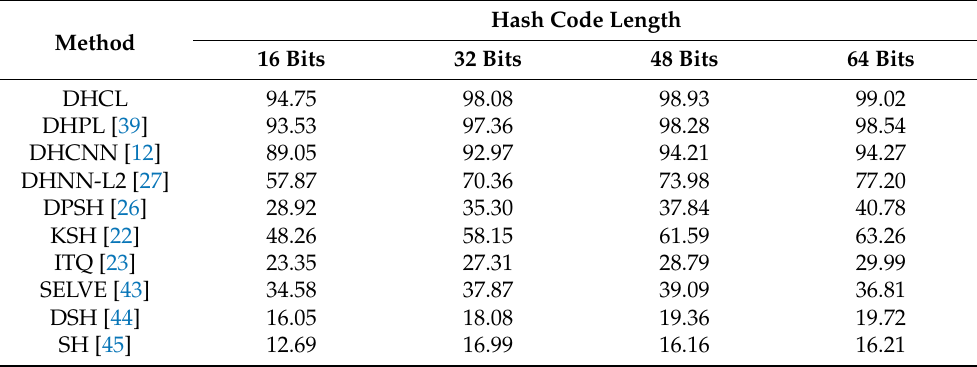
Table 2. Results of different retrieval methods on AID. The latest hash methods, including DHPL, DHCNN, DHNN-L2, DPSH, KSH, ITQ, SELVE, DSH and SH, are compared with our DHCL method. The respective lengths of the hash codes used for retrieval are set to 16 bits, 32 bits, 48 bits and 64 bits.